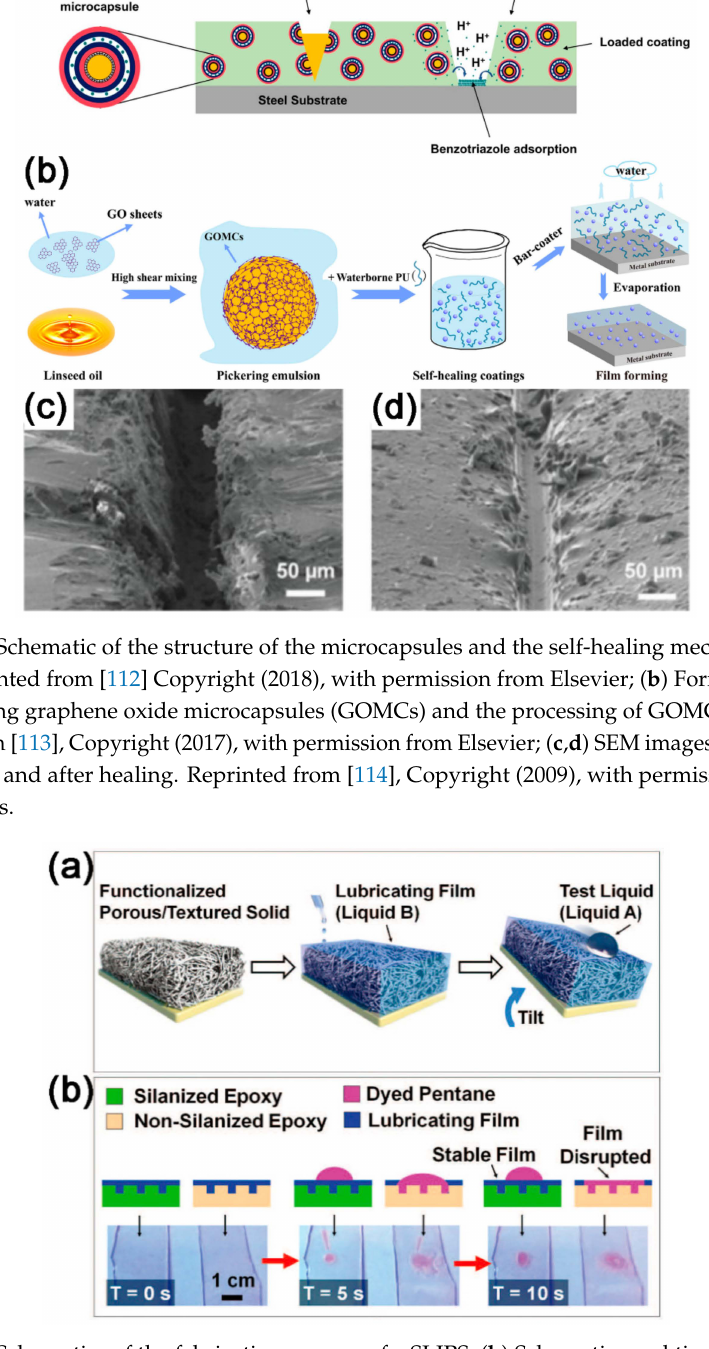
Figure 20. ( a ) Schematics of the fabrication process of a SLIPS; ( b ) Schematics and time-lapse images showing the stability and displacement of SLIPs. Reprinted from [115], Copyright (2011), with permission from Springer